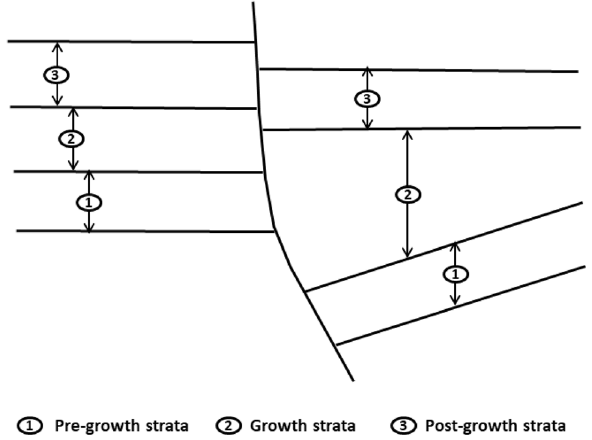
Fig. 18 Concept of pre-growth, growth and post-growth